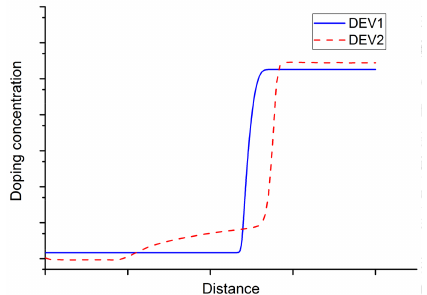
Figure 13. Comparison between the measured doping profiles of the old design (DEV1) and the new design